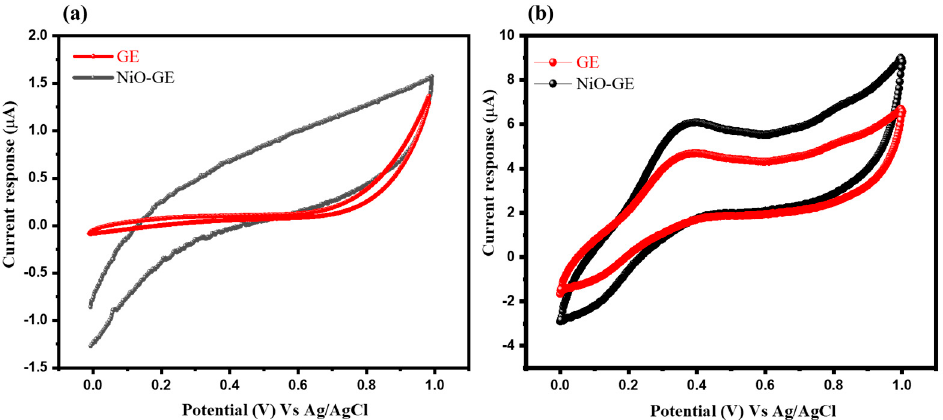
Figure 4. CV responses of GE and NiO-GE for 0 ppb ( a ) and 5 ppb As 3+ ( b ) in 0.1 M PBS (pH = 6) at scan rate = 50 mVs − 1 .